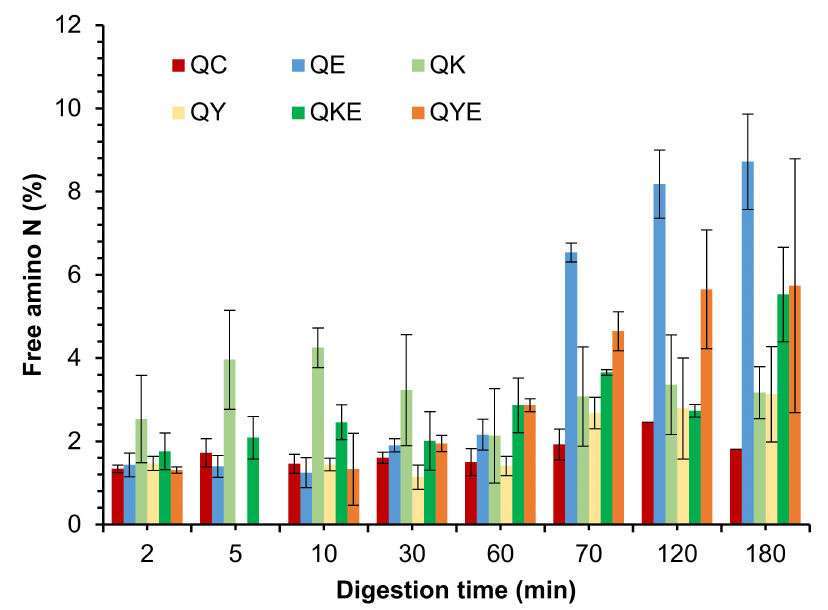
Figure 20. Free amino N (%) release during simulated gastro-small intestinal digestion of quinoa in the presence or absence of Hayward or SunGold kiwifruit extract. QC, Quinoa (Q) control without any digestive enzymes; QK/AY, with added green/gold kiwifruit extract but no digestive enzymes; QE, with digestive enzymes but no added kiwifruit extract; QKE/QKY, with both digestive enzymes and green/gold kiwifruit extract. Numbers 2, 10, 30 and 60 are the gastric digestion time following 2 min of oral digestion. Numbers 70, 120 or 180 are the total digestion times in oral-gastro-small intestinal digestion (including the first 60 min of gastric